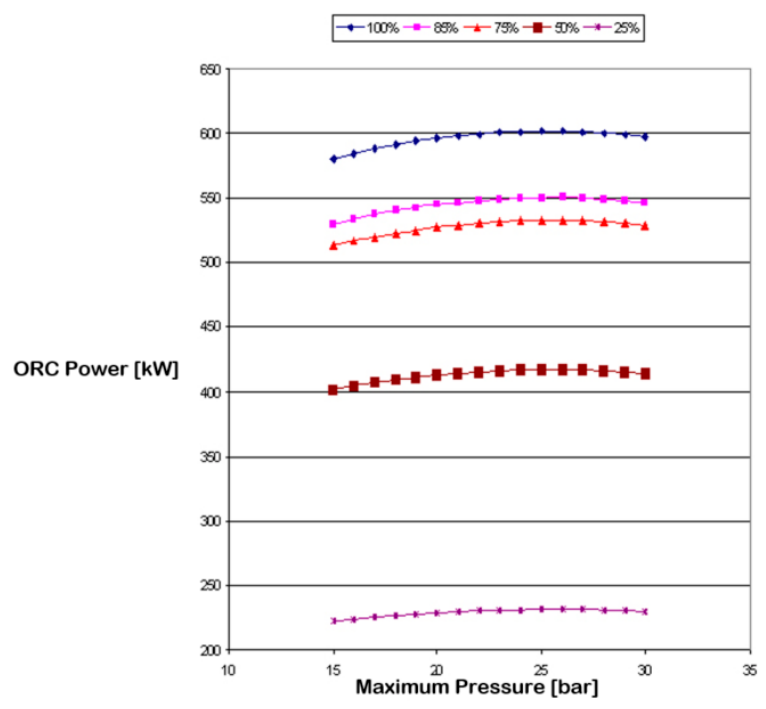
Figure 4. ORC output power vs. maximum cycle pressure, for different engine loads (cooling water temperature equal to 38 °C).